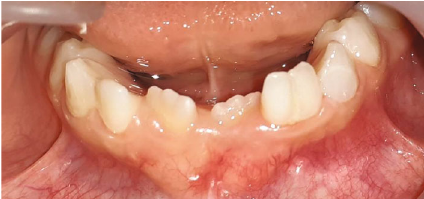
Figure 8: Placement of sealants in the groove of the fused tooth 72 and restoration of the tooth 73.